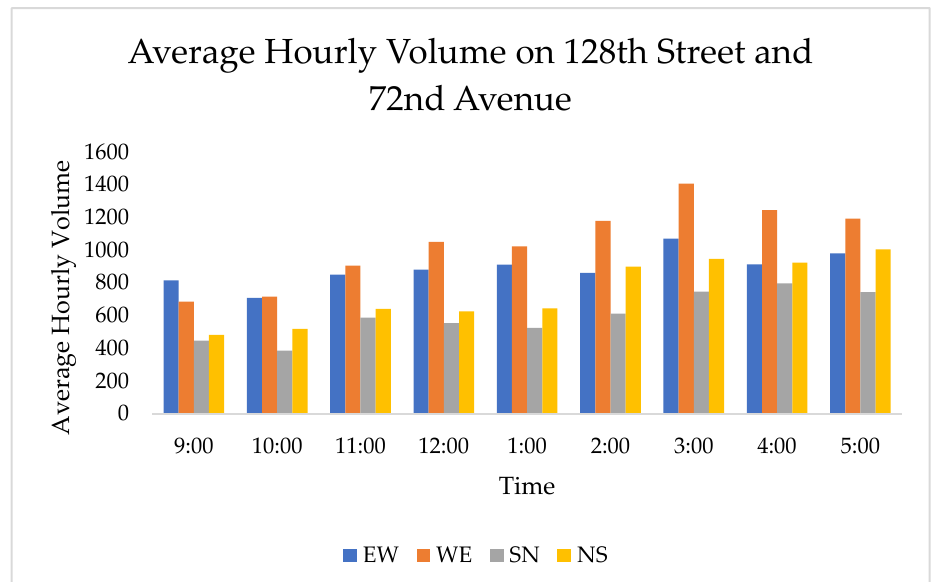
Figure 5. Hourly average traffic volumes on 128th Street and 72nd Avenue.